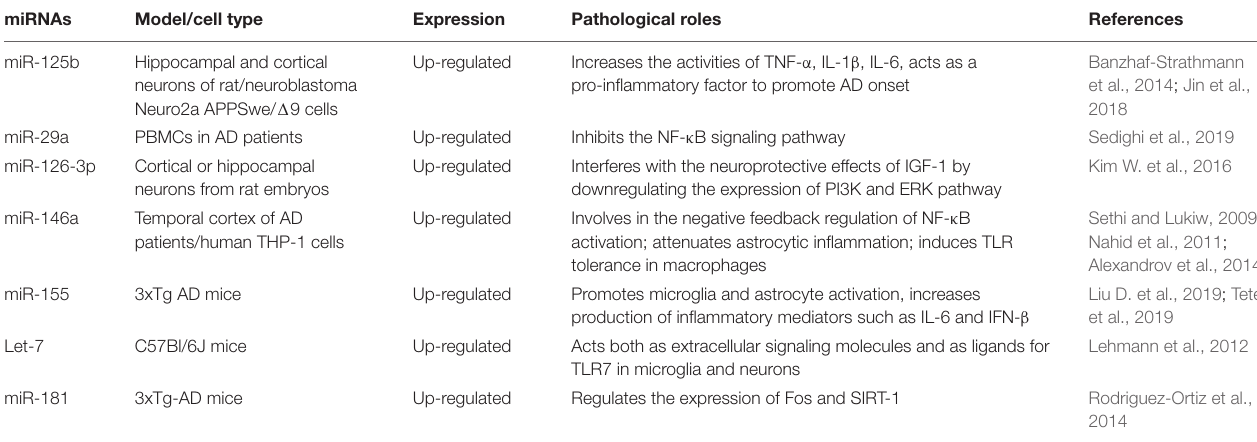
TABLE 1 | The key inflamma-miRNAs involved in the pathogenesis of Alzheimer’s disease.